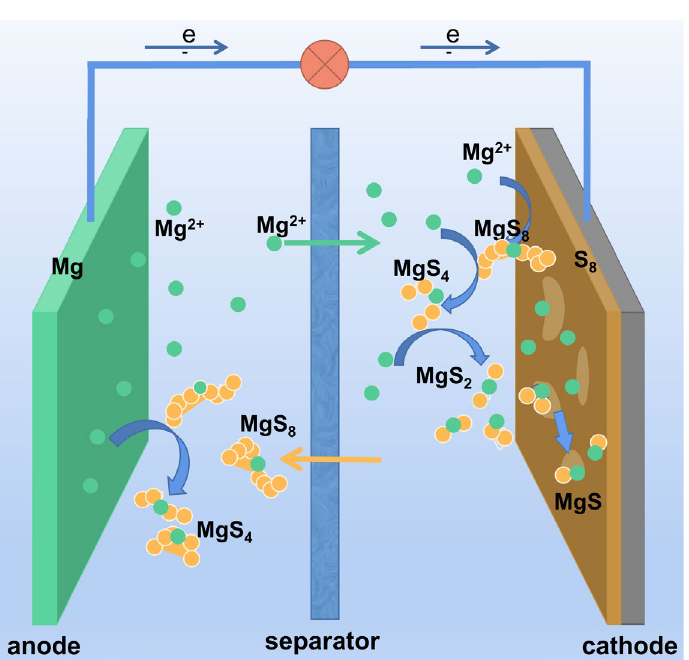
Figure 2. Illustration discharge reaction mechanism for Mg −S batteries.